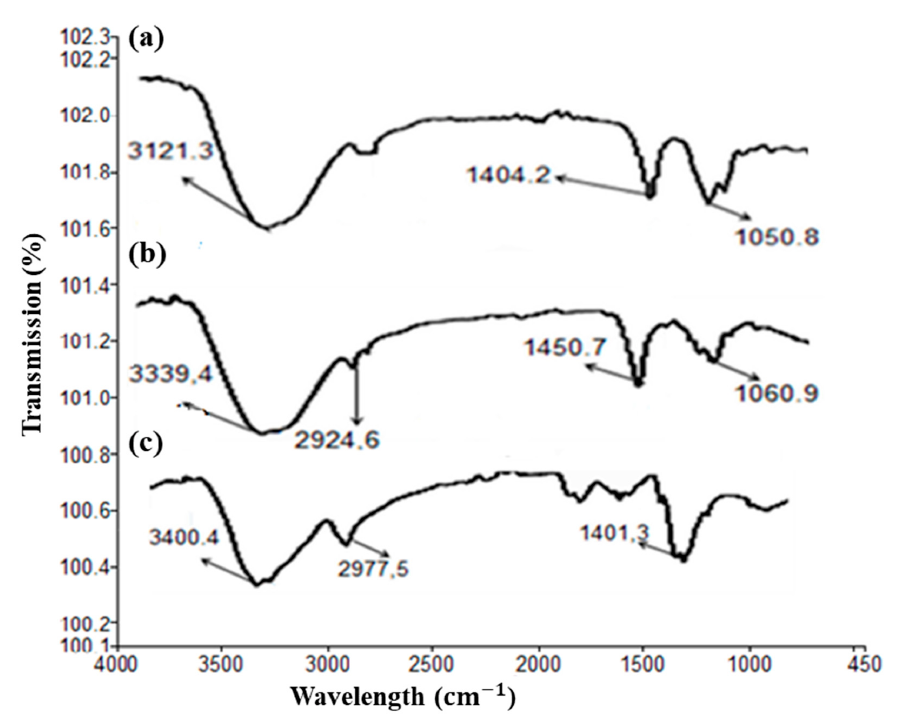
Figure 4. FT-IR of alginate (a), FA-CS-5FU-NPs beads, (b) and pure chitosan